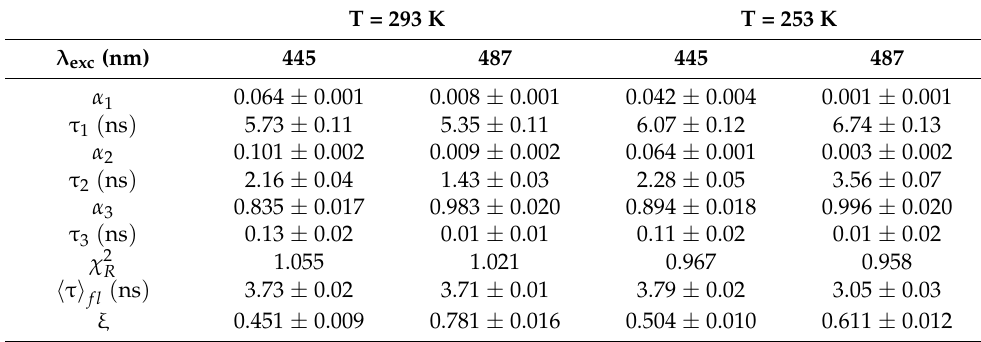
Table 2. Temperature-dependent parameters of the FMN fluorescence decay in PVA rigid solution at concentration of C = 6.8 × 10 − 1 M, fitted to the sum of three exponentials. The observation wavelength was λ obs = 530 nm. The mean lifetimes (cid:104) τ (cid:105) (ns) and the degree of nonexponentiality ξ fl are calculated from Equations (9) and (10), respectively. The parameters were estimated from the best fit with the data with calculated standard deviations.